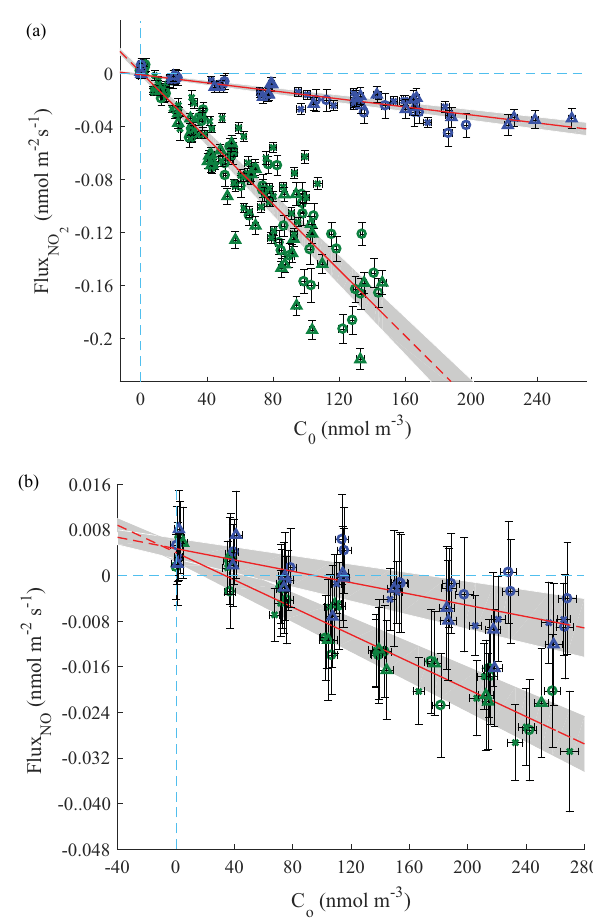
Figure 4. NO 2 (a) and NO (b) fluxes versus the outlet concentra- tions for all Quercus agrifolia individuals with the chamber lights on (green) and off (blue). The line of best fit is shown in red and was calculated to minimize the weighted residuals in both the x and y axes. The blue dotted lines show where flux and C o are zero. A significantly positive ( α = 0 . 5) x intercept occurs for NO, but not NO 2